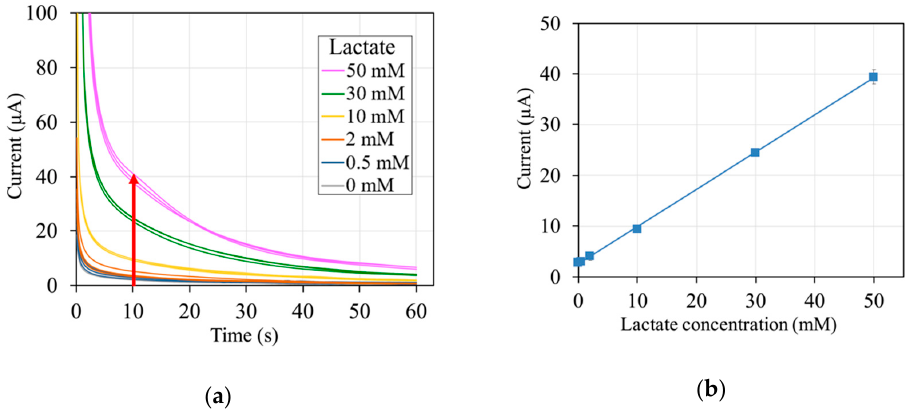
Figure 2. Response currents of lactate sensors; ( a ) time courses and ( b ) calibration curve (linear regression: y = 0.73x + 2.5; R 2 > 0.99). The arrow in ( a ) indicates increasing lactate concentration. Sensor composition: 1 U Av LOx A96L, 100 nmol mPES, 40 µ g sucrose, and 20 µ g Tween 20. Waiting